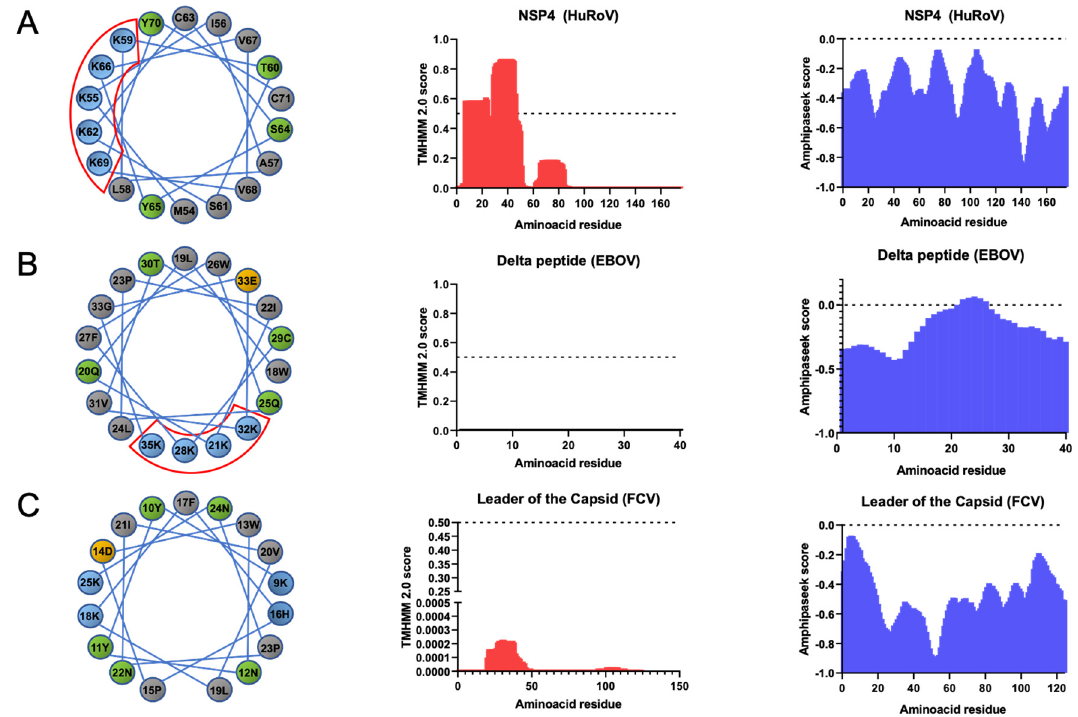
Figure 1. LC protein from FCV does not have the biochemical characteristics of several viroporins. Bioinformatical analysis of the NSP4 protein from ( A ) HuRoV, ( B ) delta peptide from Zaire EBOV, or ( C ) the WT-LC protein from FCV Urbana strain. Distribution of amino acids in a helical wheel using NetWheels (left), prediction of TMDs with TMHMM 2.0 with score threshold of 0.5 (center), and prediction for amphipathic helixes with AmphipaSeeK with a score threshold of 0 (right) are shown. Polybasic region of NSP4 and delta peptide enclosed in red.